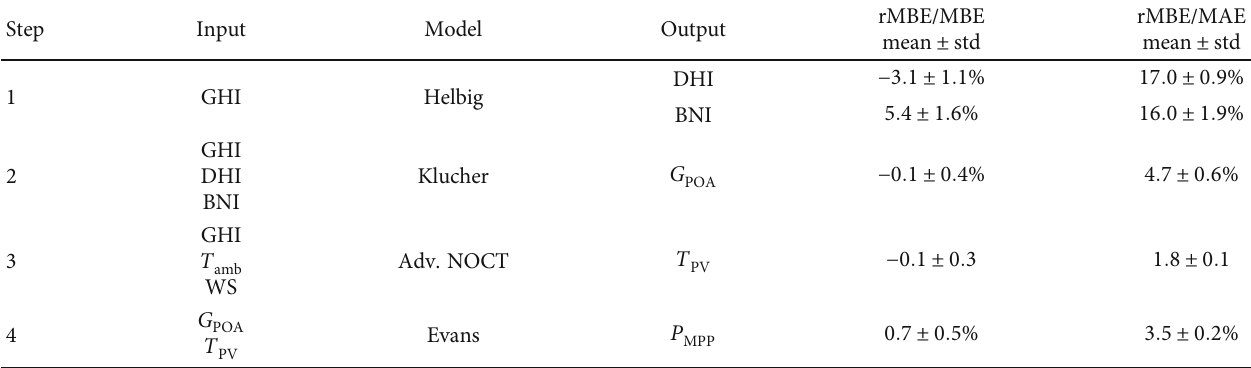
Figure 6: rMAE and rMBE of the presented models to calculate P Appendix B. Table 3: Best results for each modeling step considering SIRTA in situ ground measurements. All computed data can be found in Figure 9 of Appendix